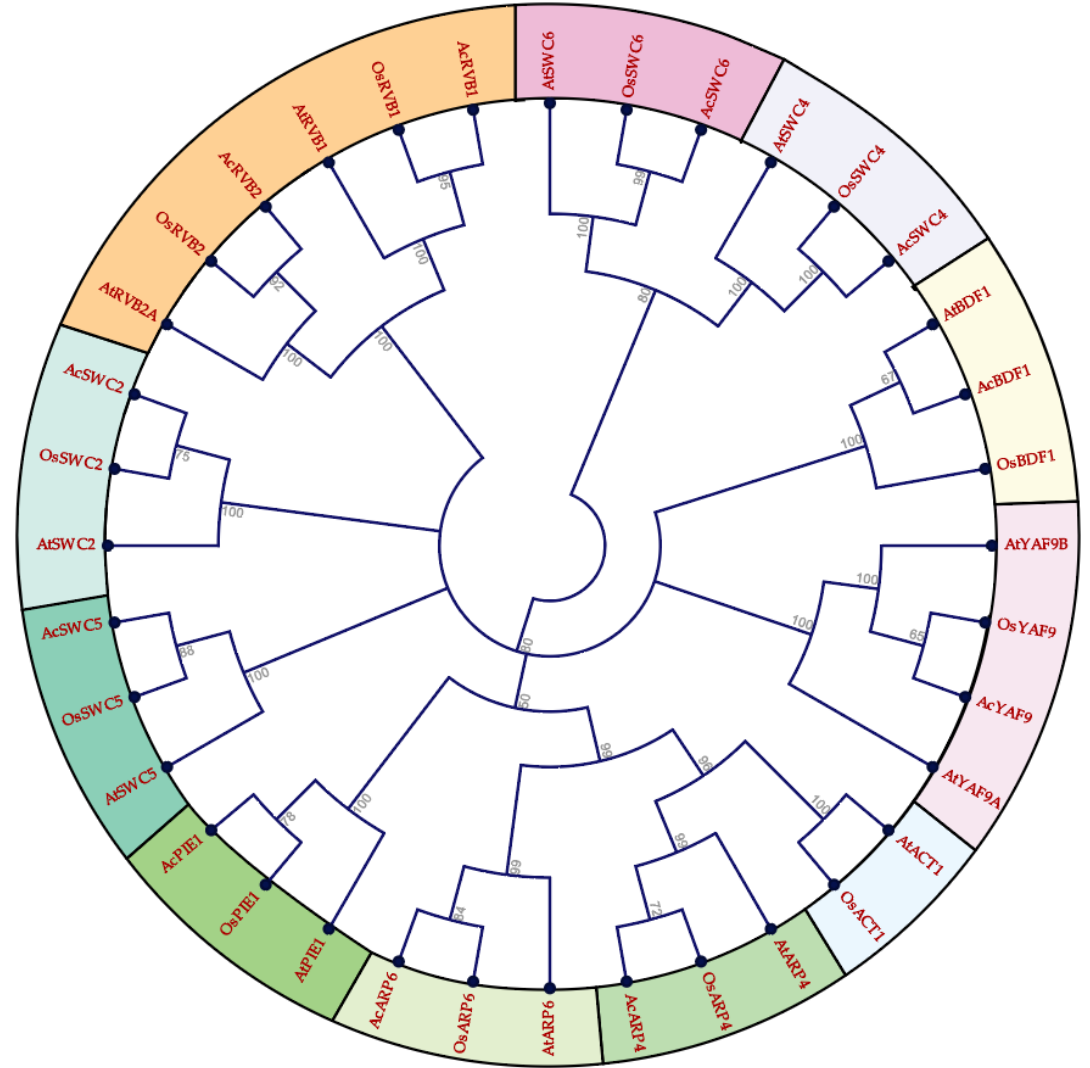
Figure 1. Phylogenetic tree indicating the relationships among SWI2/SNF2-Related 1 chromatin remodeling complex (SWR1-C) subunits from pineapple, rice, and Arabidopsis . Prefixes ‘At’, Os , and ‘Ac’ indicate SWR1-C proteins from Arabidopsis , Oryza sativa , and Ananas comosus respectively. Biomolecules 2019 , 9 , x 7 of 20 For structural divergence of the SWR1-C subunits in pineapple, the exon – intron structures were further investigated. An exon – intron structure was constructed using the Gene Structure Display Server 2.0 (GSDS) (Figure 2). The result revealed that among the SWR1 complex subunits, only Ac SWC2 and Ac BDF1 have the same numbers of exons and introns, while other subunits of the complex exhibit variation of exon and intron numbers. The difference in exons, introns, and UTR length in the SWR1-C suggests that the subunits may have different roles to play during the growth and developmental processes of pineapple [43].